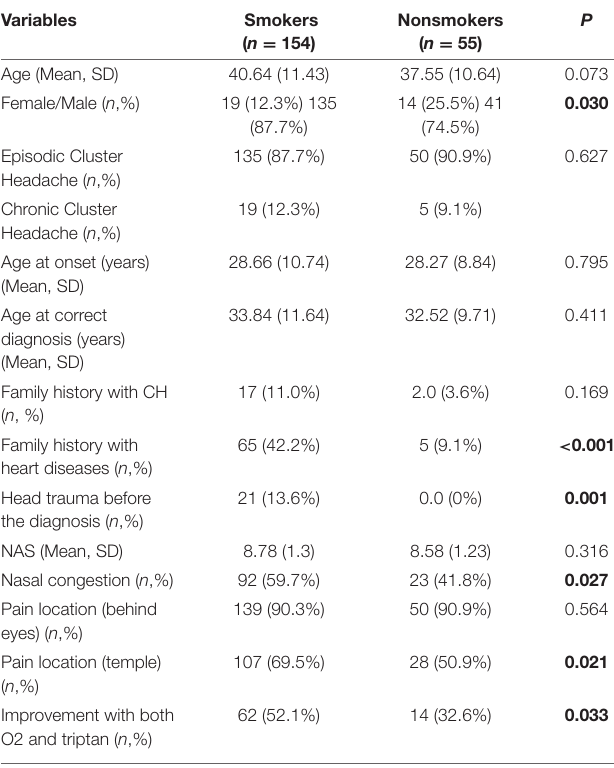
TABLE 4 | Comparison of two groups who never smoked vs. those who smoked/exposed.